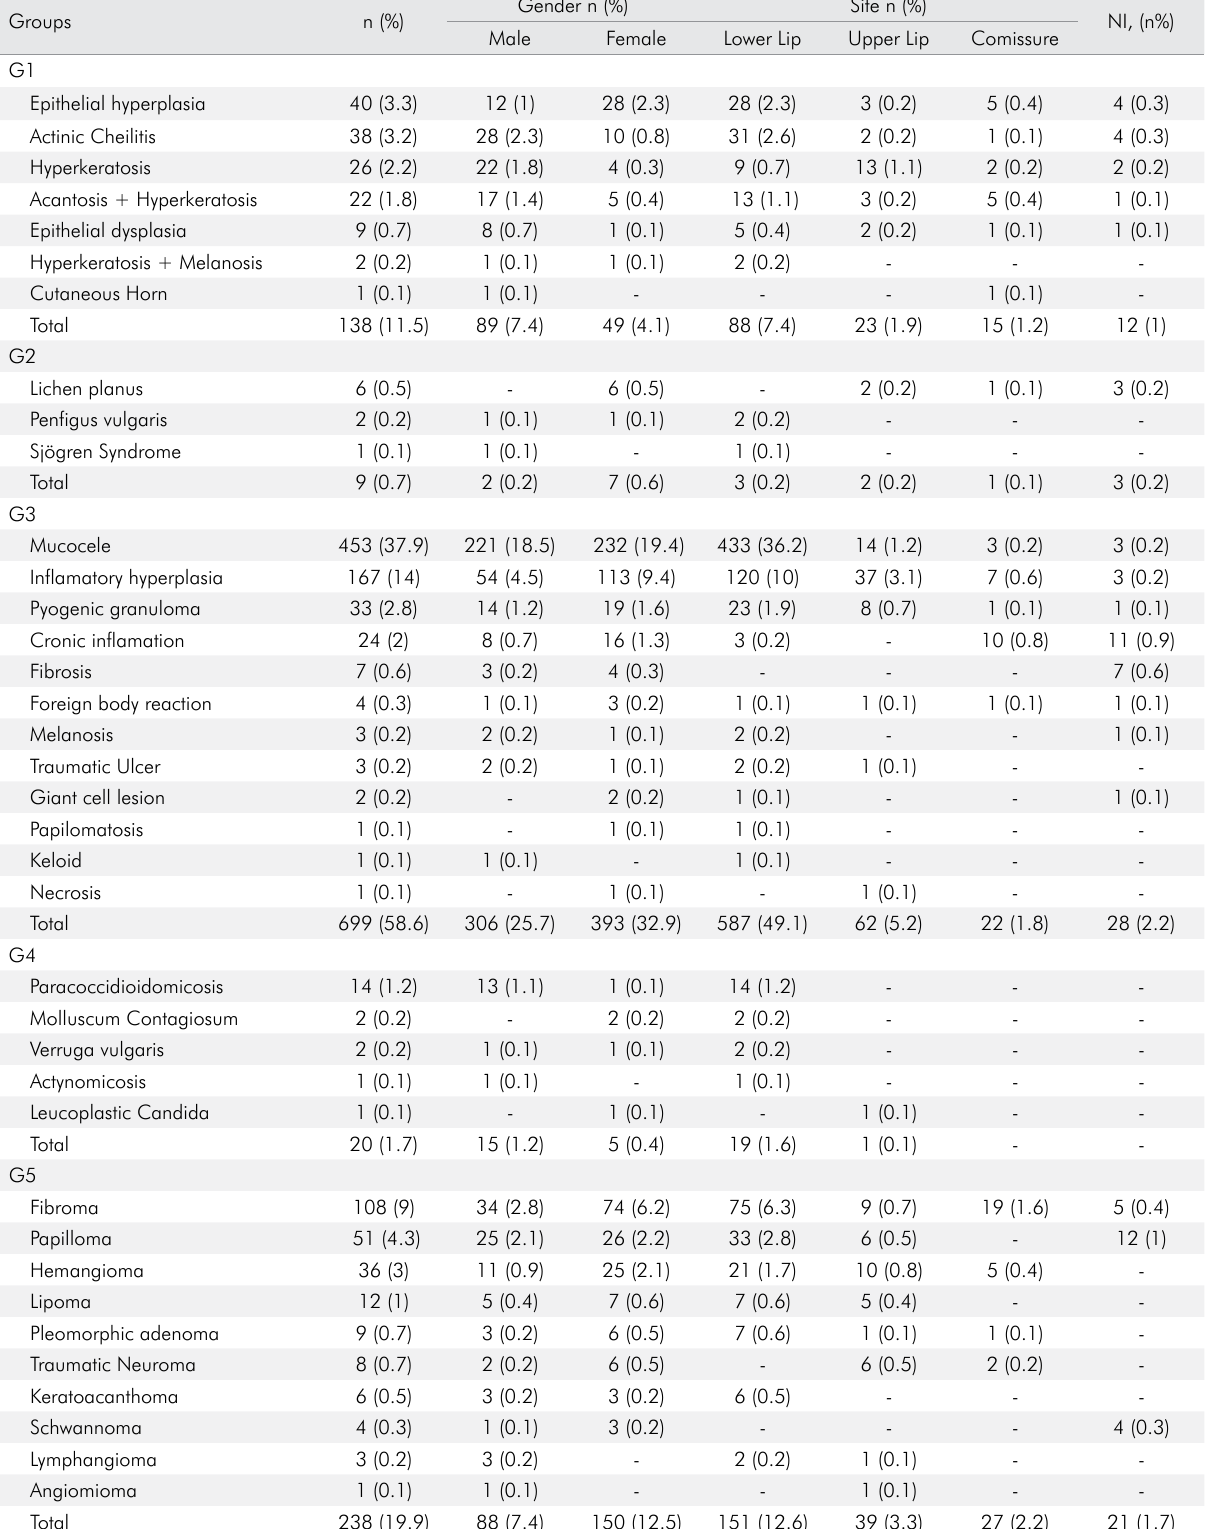
Table 1. Histopathological distribution of lip lesions according to gender, age and affected site (n = 1195).